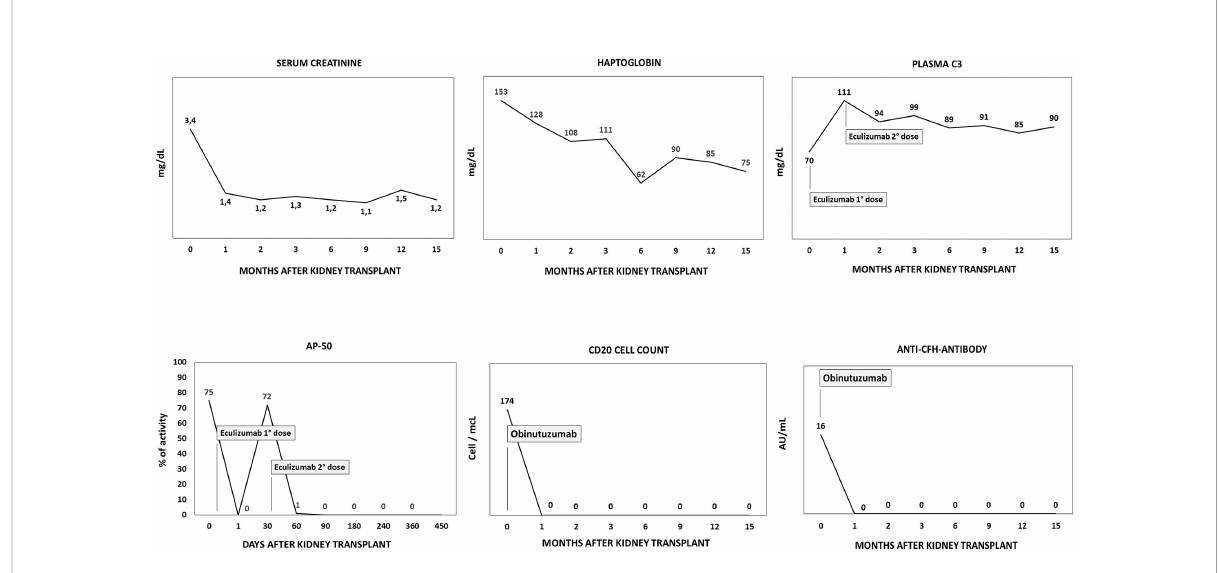
FIGURE 2 Main peri-transplant and post-transplant DEAP-HUS-related parameters.